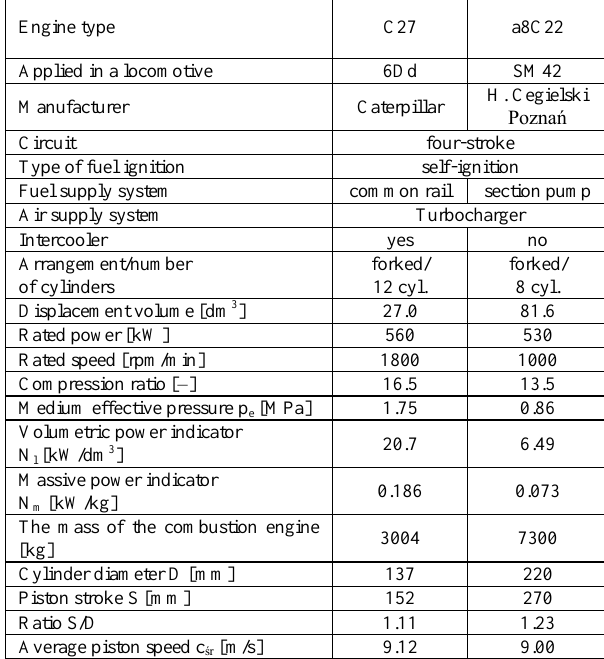
Table 1. Characteristics of the used fuels Property